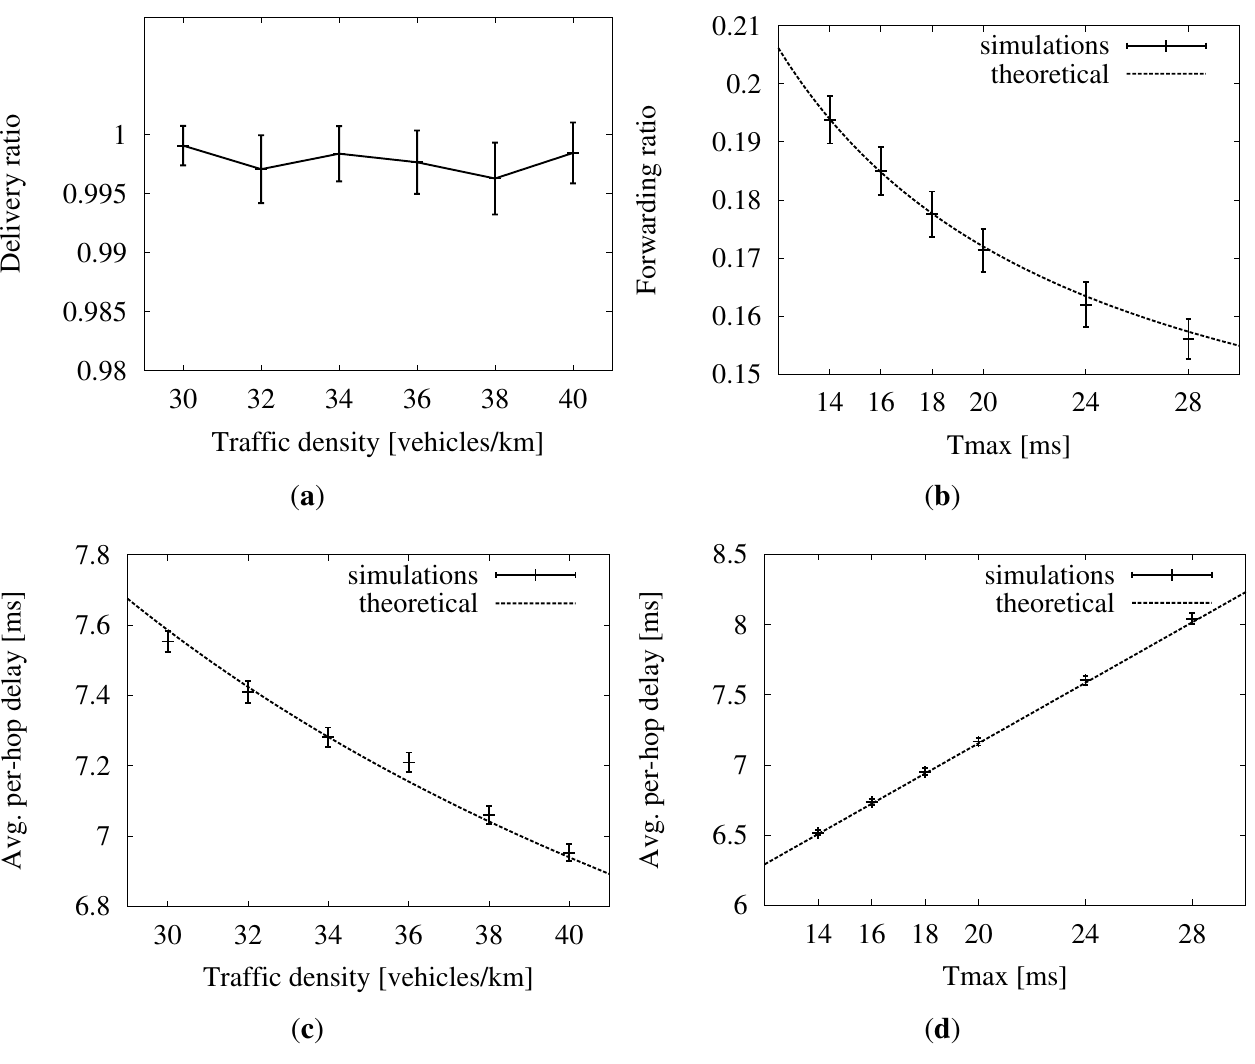
Figure 11. Simulation results, compared to theoretical values. Confidence interval of 95%. = 18 ms); ( b ) forwarders/receiver ( ρ = 40 vehicles/km); ( c ) ( a ) Coverage ( T max